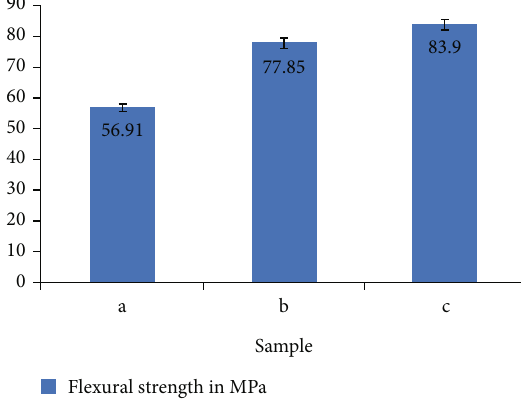
Figure 5: Flexural strength of epoxy hybrid